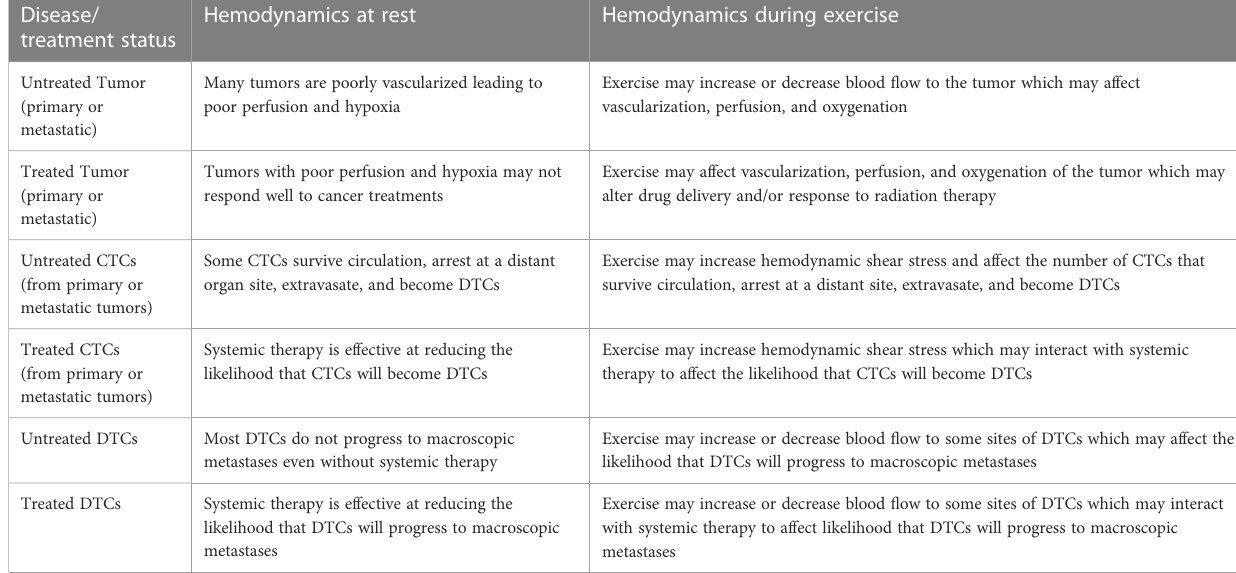
TABLE 6 Potential hemodynamic effects of exercise based on tumor/disease and treatment status. Disease/ Hemodynamics at rest Hemodynamics during treatment status